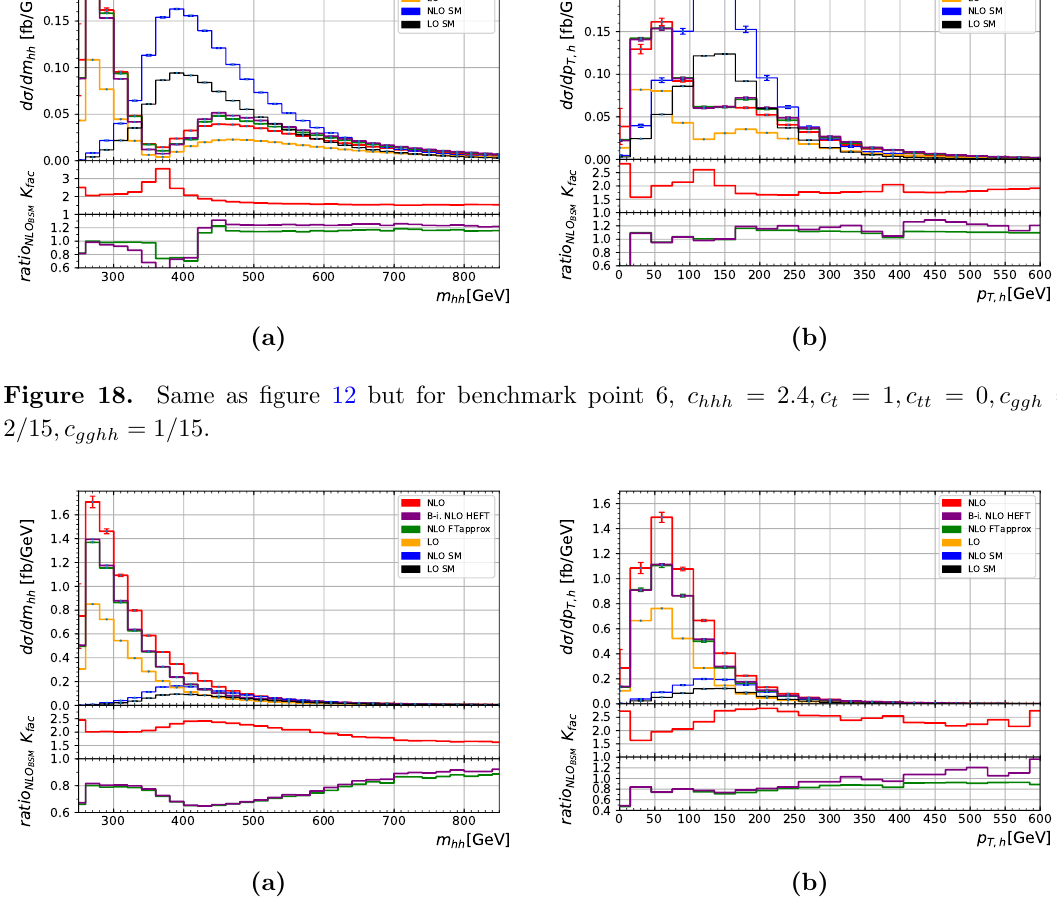
Figure 19. Same as (cid:12)gure 12 but for benchmark point 7, c hhh = 5 ; c t = 1 ; c tt = 0 ; c ggh = 2 = 15 ; c gghh = 1 =